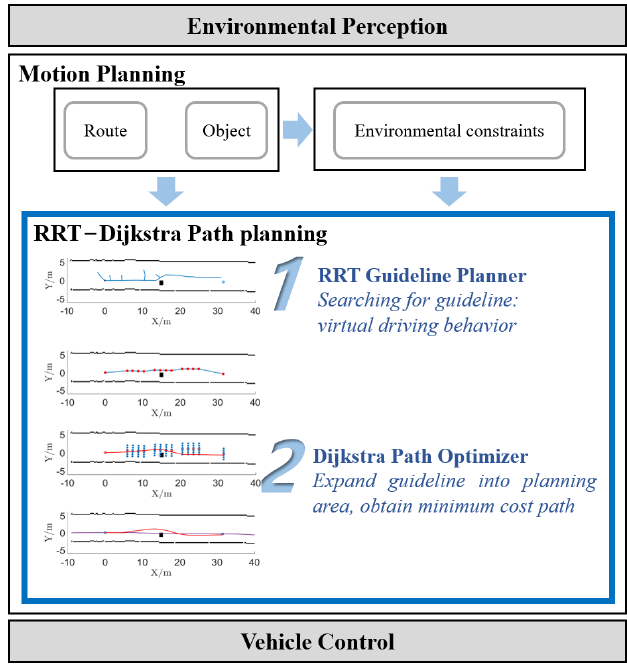
Figure 1. Strategy architecture.